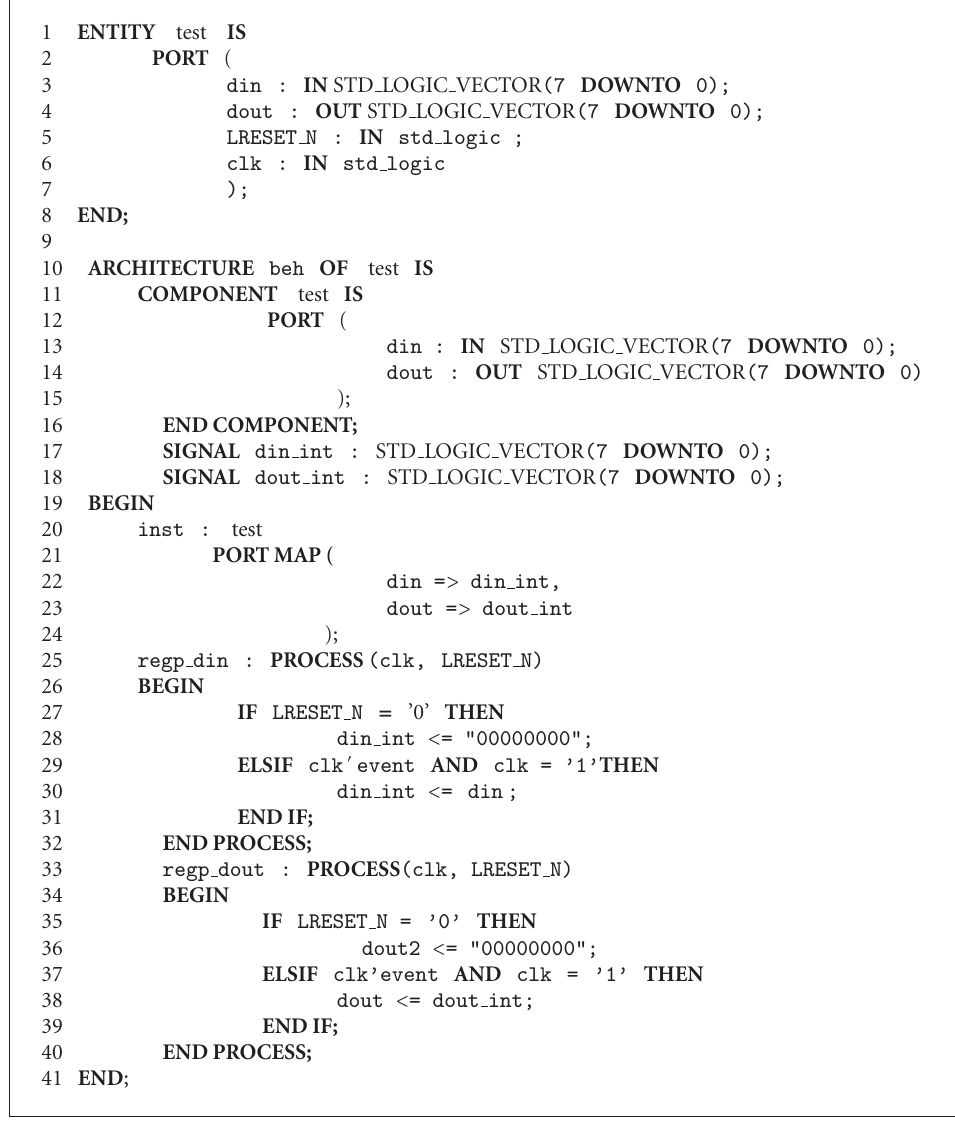
Algorithm 2: VHDL output of the example Java program. The indentation and the notation of keywords is governed by the String Template file and can be changed to fit the developers